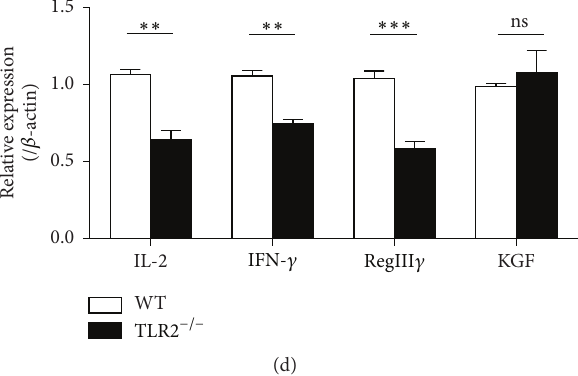
Figure 3: Alterations in IEL activation, proliferation, apoptosis, and cytokine mRNA expression after TLR2 knockout. (a) The surface expressionofCD69onIELswasdetectedbyflowcytometry.(b)TLR2 −/− andwild-typemicewereinjectedwithBrdUtwiceperday.After24 h, BrdU incorporation in the indicated IEL subsets was analyzed by flow cytometry. (c) Intestinal IELs were examined through flow cytometry for CD45 and apoptosis markers (FITC-Annexin V and PI). In the apoptosis map, FITC-Annexin V+/PI+ indicates late apoptosis, FITC- Annexin V+/PI − indicates early apoptosis, and FITC-Annexin V − /PI − indicates live cells. (d) Changes in the small intestinal IEL-derived cytokine mRNA measured using real-time RT-PCR. The results were expressed as the ratio of the number of copies of the gene of interest to the number of copies of the 𝛽 -actin gene. Five mice per group. Representative of three experiments. ∗∗ 𝑃 < 0.01 ; ∗∗∗ 𝑃 < 0.001